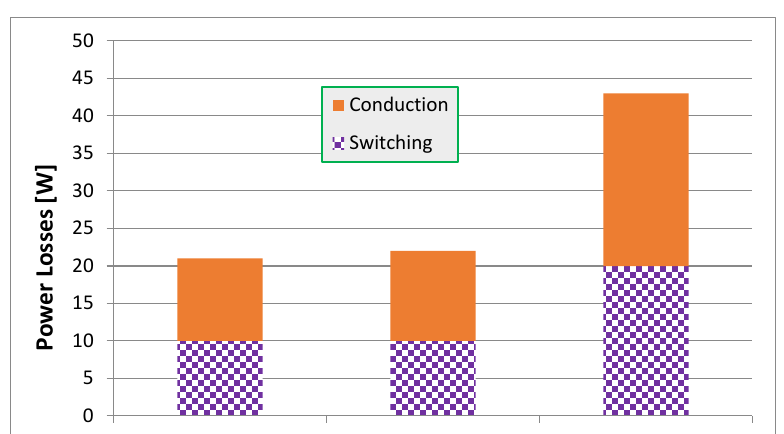
Energies 2020 , 13 , x FOR PEER REVIEW